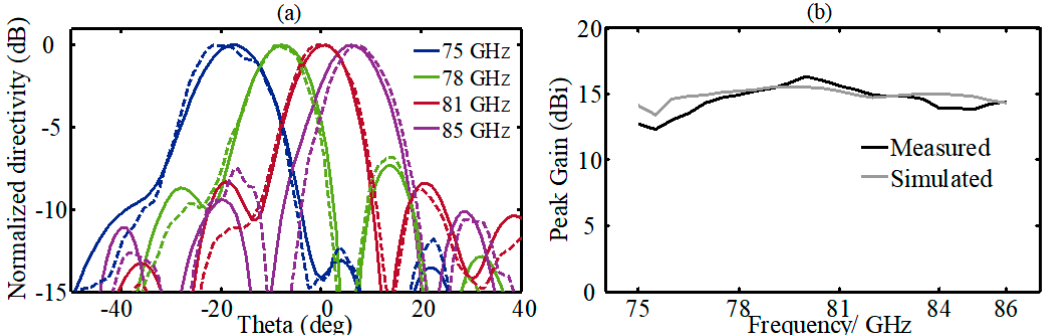
Figure 7. Magnitude of the reflection coefficient for the two-row prototype adapted for probe measurements. The black dots represent the measurement taken directly from the VNA, whereas the blue curve represents the measurement after de-embedding the probe and the interconnection.